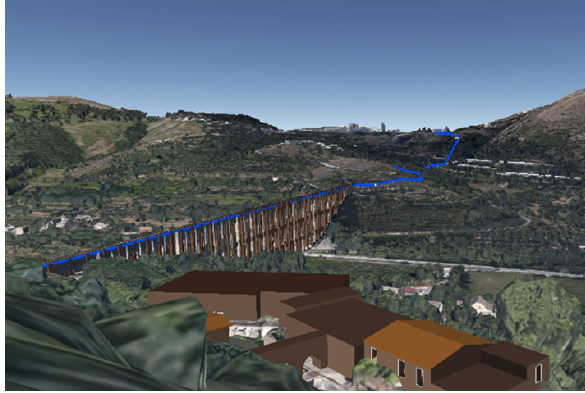
Figure 10 . ‘Carolino’ Aqueduct. WebGIS system (Credit: Vincenzo Migliaccio).